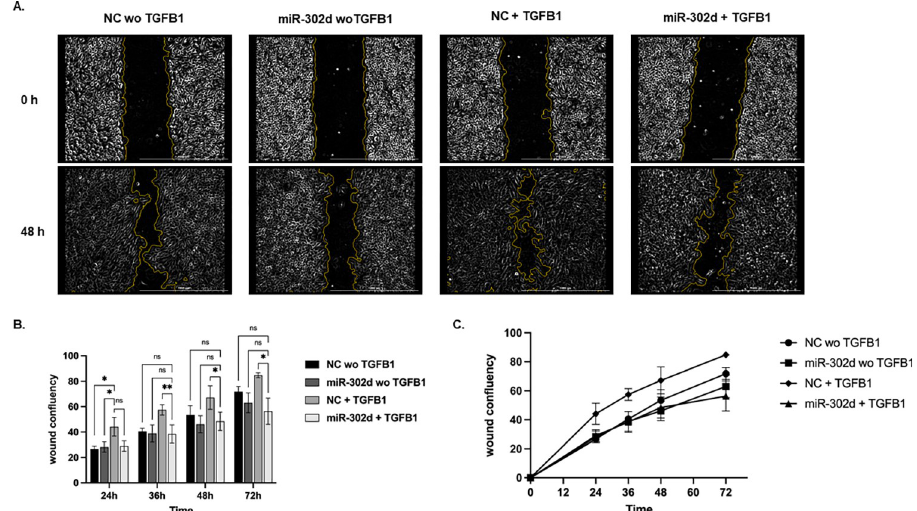
Fig 5. miR-302d suppresses TGFB-induced migration in hRPE cells. A scratch was generated in the monolayer of hRPE cells transfected with miR-302d or NC using a 200- μ l pipette tip. Serum-free medium with or without TGFB1 was added and monitored for 72 h. (A) Representative scratch image after background subtraction with Gen5 software at the beginning and 48 h. The scale bar represents 1000 μ m. (B) (C) The wound confluency over time. Two-way ANOVA with Fisher’s LSD tests (n = 3) were performed. The error bars represent SD. ns, non-significant, � p < 0.05, �� p < 0.01.